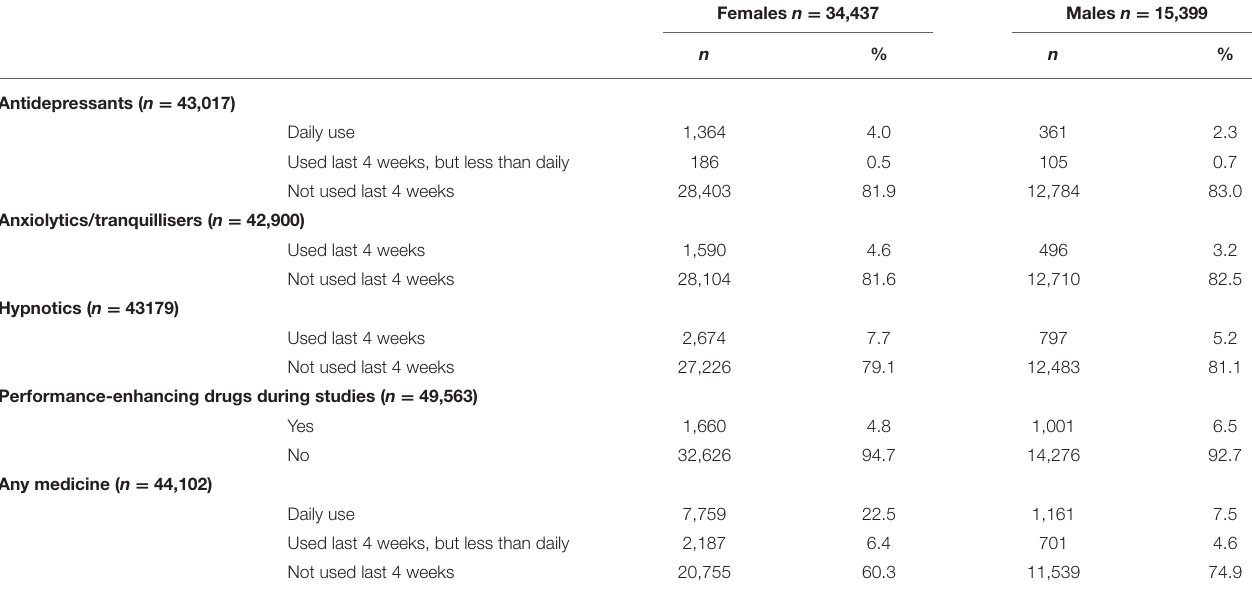
Females n = 34,437 Males n = 15,399 n % n %